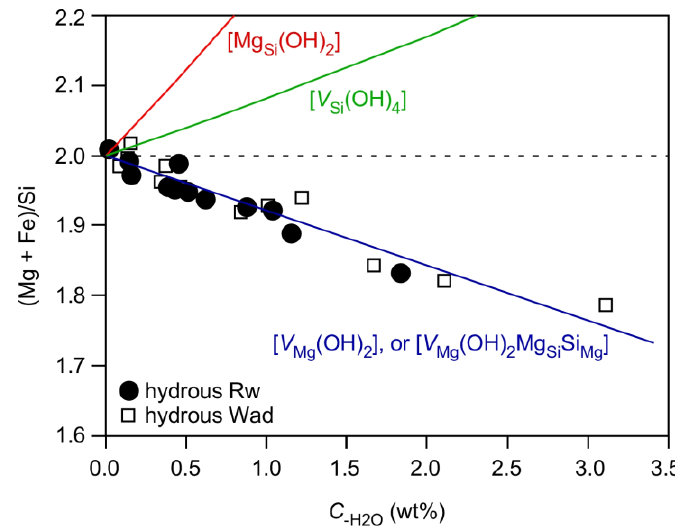
Figure 13. Effects of different types of hydrogen defects on (Mg + Fe)/Si ratios of Rw with various Mg/Fe ratios. Data are from Bolfan-Casanova et al. [56] (data from experiments 224 and 271 excluded due to typing mistakes). For the purpose of comparison, the data for hydrous wadsleyite (Wad) from Bolfan-Casanova et al. [56] are also plotted. The C H2O contents of these Rw and Wad were obtained via elastic recoil detection analyses.